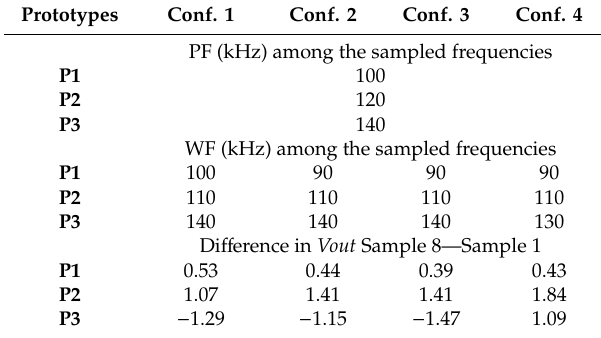
Figure 7. Representation of the frequency spectrum of P1 in the four different studied cases. Table 4. Frequency and Vout di ff erence for P1, P2, and P3 and their four configurations (Conf.). Prototypes Conf. 1 Conf. 2 Conf.